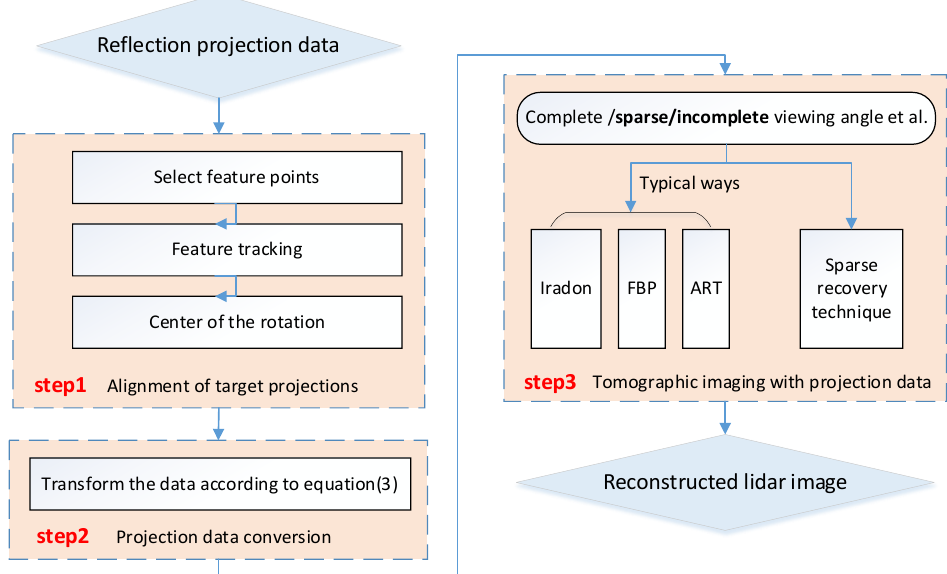
Figure 4. Flowchart of image reconstruction by projection data.